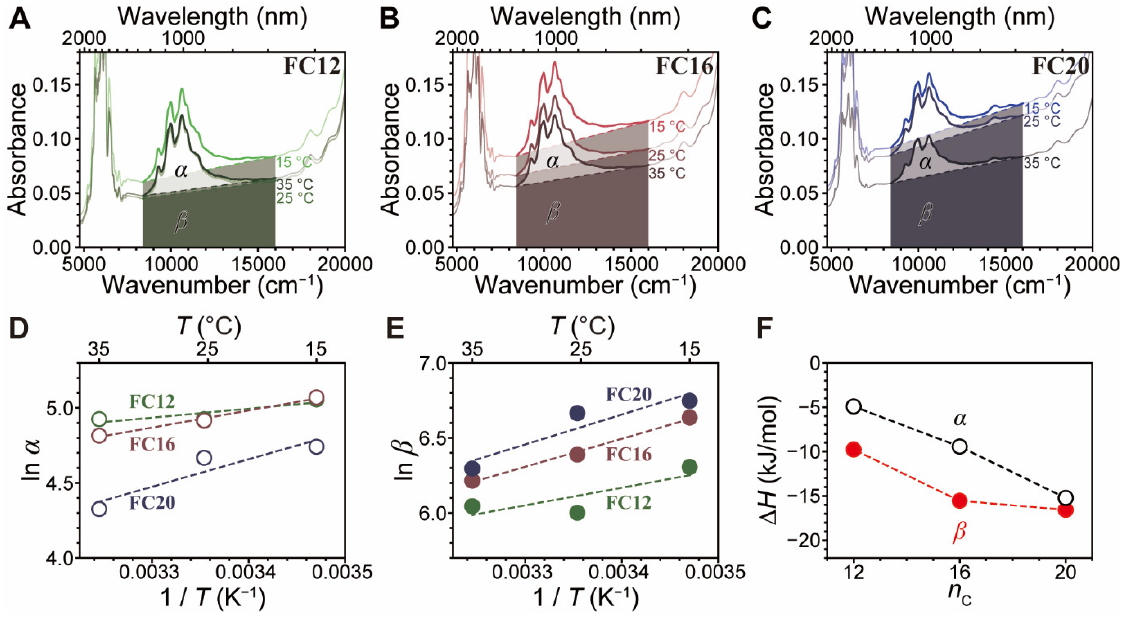
Figure 9. Sonication bath temperature dependent absorption spectrum change according to l S . Changes of α from ( A ) FC12 -, ( B ) FC16 -, and ( C ) FC20 -PSWNT dispersions which were prepared by sonication at 15, 25, and 35 °C (from light to dark colors), respectively. Gray shades denote β . van’t Hoff plots for ( D ) α and ( E ) β from FC12 - (green), FC16 - (purple), and FC20 -derived dispersions (blue) at 940 nm vs. reciprocal sonication temperatures. The solid lines show the linear regressions from each point. ( F ) ∆ H vs. α and β according to number of carbon atom in flavin side chain ( n c ). The dotted lines are drawn for visual guidance.